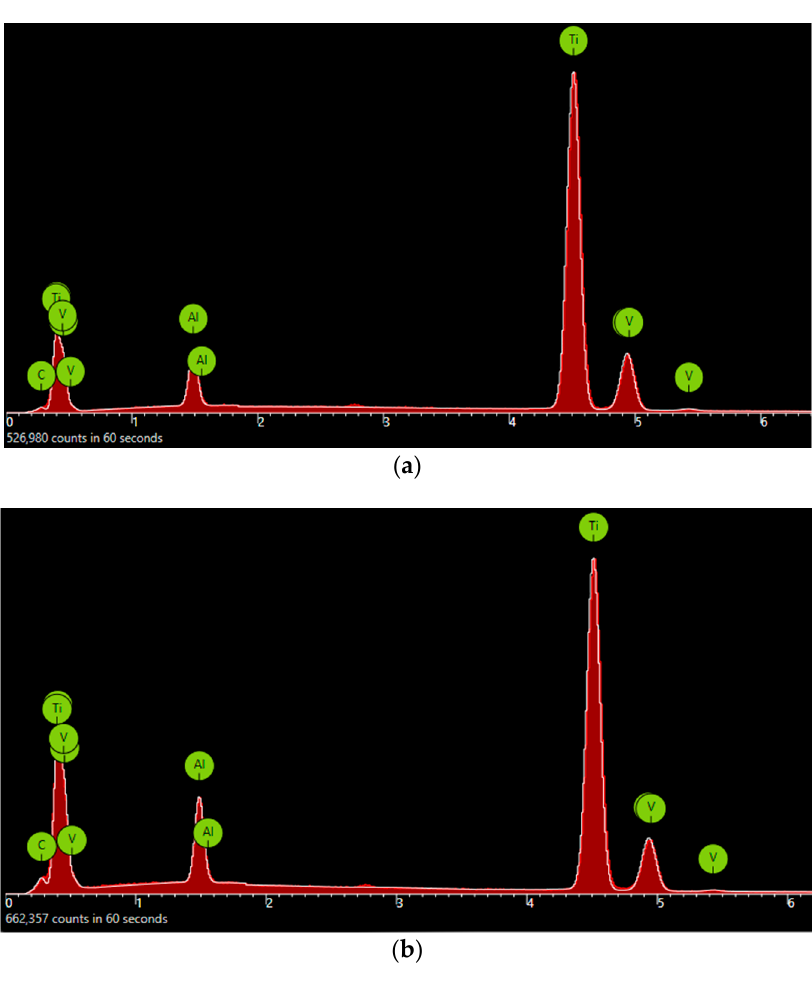
Figure 8. Energy-dispersive X-ray spectroscopy on BE samples ( a ) and BTK samples ( b ). X -axis represents the energy (KeV) and Y -axis represents the number of counts. The highest peak is titanium but an average of 1.25% and 3.65% of carbon can be detected in the BE and BTK samples, respectively.